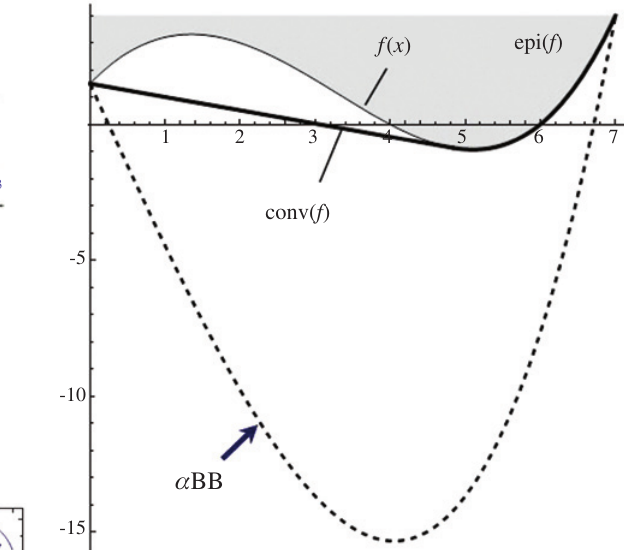
Figure 5: Convex lower bounding function in Example 5.